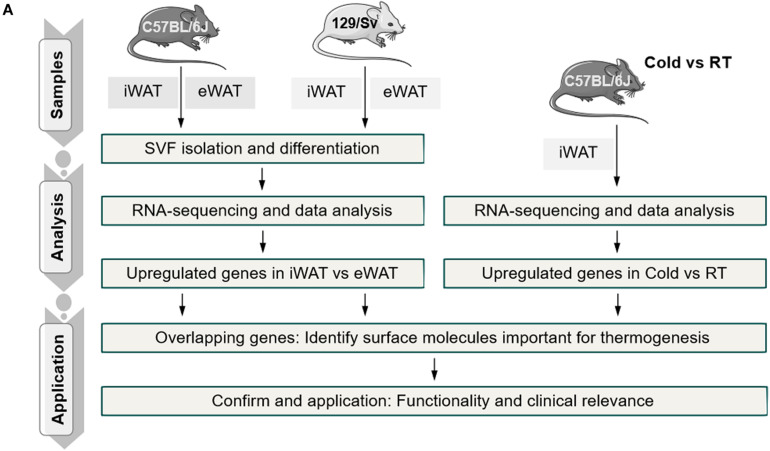
Schematic representation of the experimental workflow.